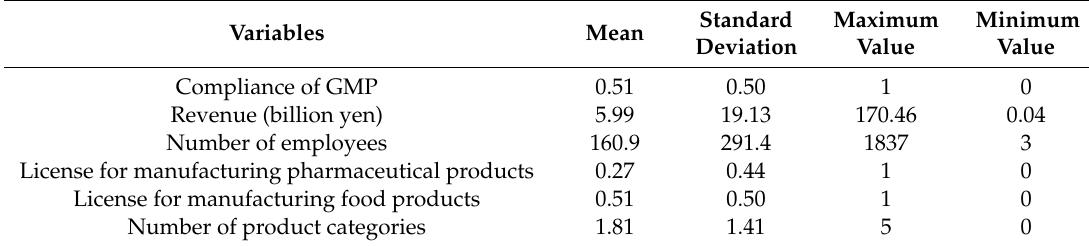
Table 1. Descriptive statistics of the samples (90 original equipment manufacturers (OEMs) in the Japanese dietary supplement